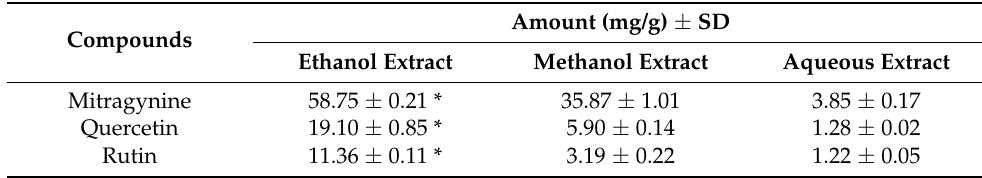
Table 3. Quantitative analysis of mitragynine, quercetin, and rutin of kratom extracts.